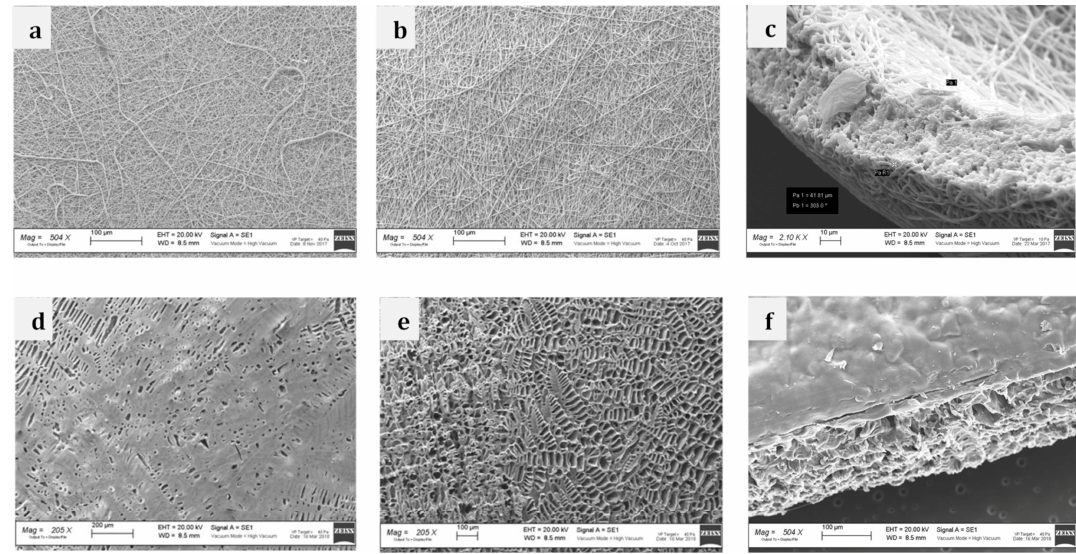
Figure 3. Scanning electron microscopy images of ( a ) EL-M PLA:PCL 85:15 layer; ( b ) EL-M PLA:PCL 70:30 layer; ( c ) EL-M bilayer cross section; ( d ) TIP-F PLA:PCL 85:15 layer; ( e ) TIP-FPLA:PCL 70:30 layer; ( f ) TIP-F bilayer cross section. EL-Ms and TIP-Fs corresponds to bilayer electrospun matrices and temperature induced precipitation porous films, respectively.